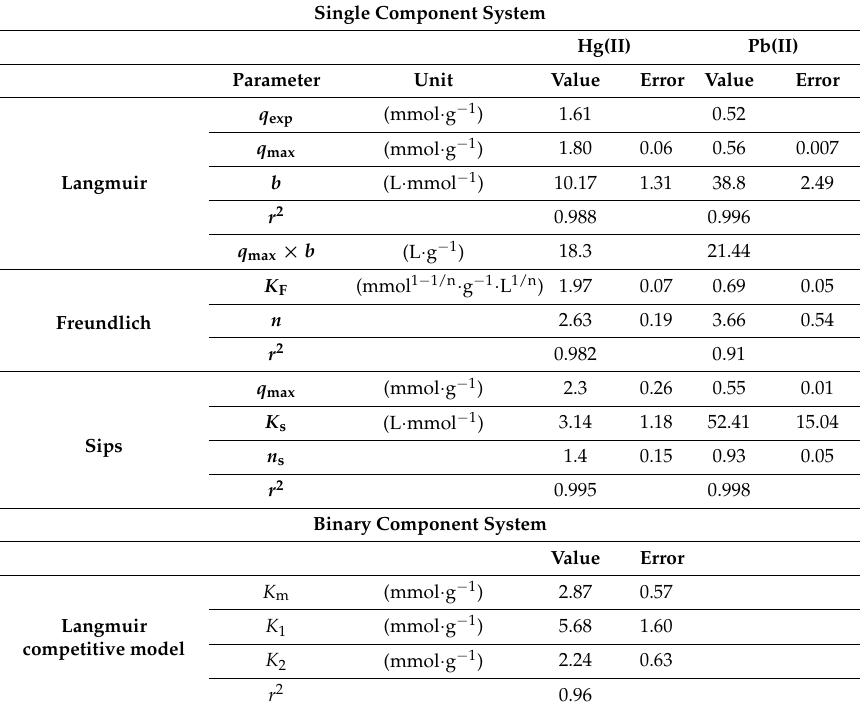
Table 1. Single and binary component isotherm constants of ChiFer(III) material.